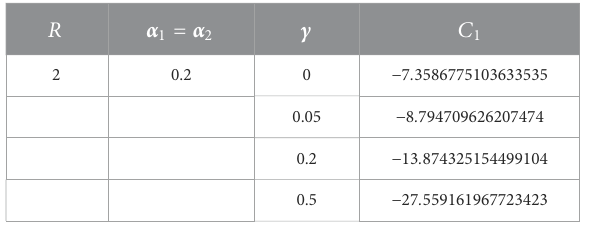
for different slip 1